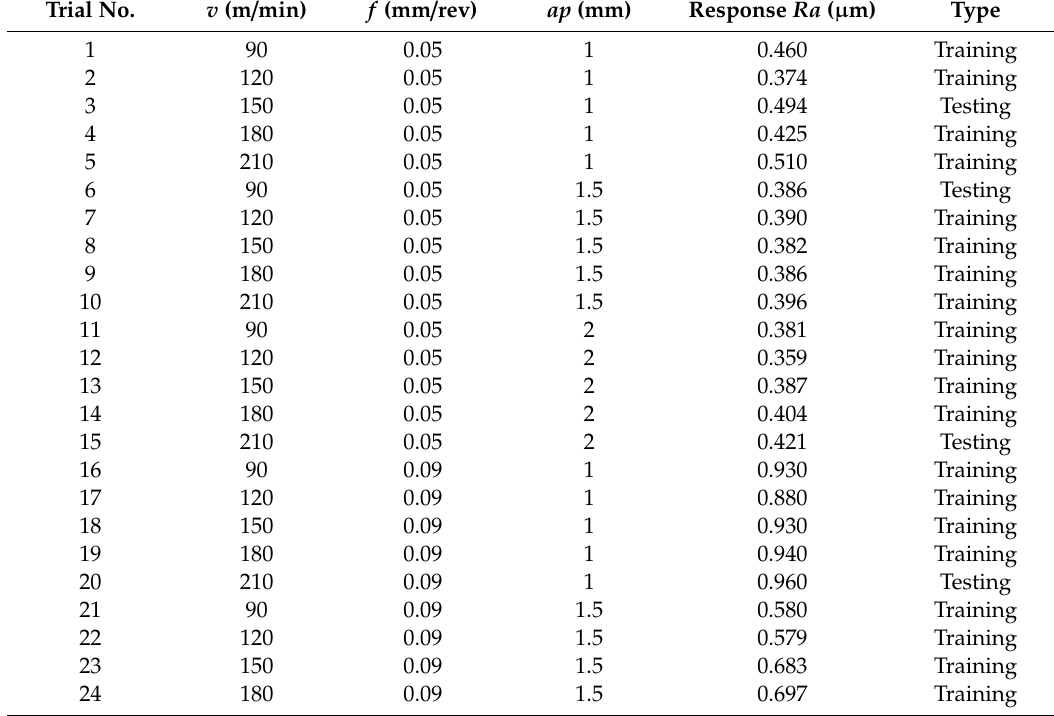
Table 4. Experimental